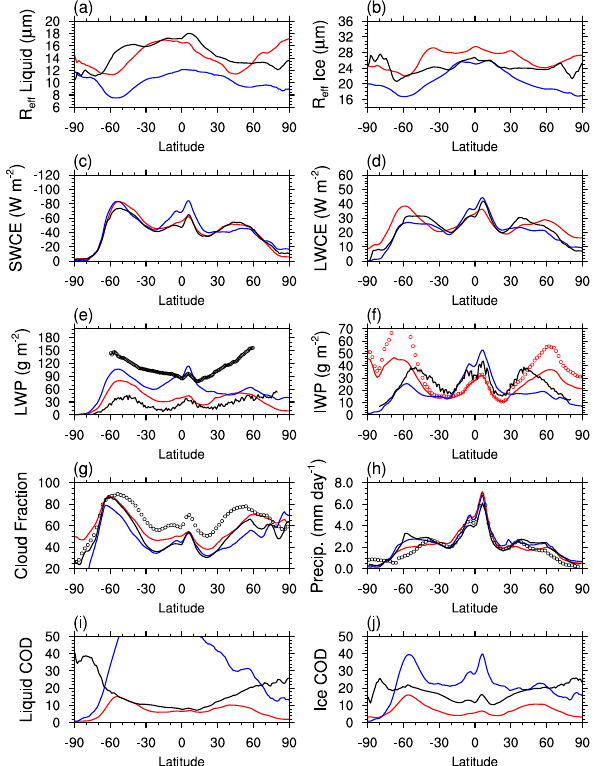
Figure 15. Annual zonal means from the GEOS-5 model for the CTL (blue lines) and NEW (red lines) runs compared against dif- ferent observations (black lines). (a, b) Liquid ( R eff , liq ) and ice ( R eff , ice ) effective radius from COSP output against MODIS. (c, d) Shortwave (SWCF) and longwave (LWCF) cloud forcing against CERES-EBAF retrievals (Loeb et al., 2009). (e) Liquid water path against CloudSat (black lines) and MODIS (black circles) retrievals. (f) Non-convective, non-precipitable ice water path against Cloud- Sat retrievals (Li et al., 2012, 2014). Also shown is the total (ice and snow) non-convective ice water path (red circles) from GEOS-5 us- ing the new microphysics. (g) Total cloud fraction from COSP out- put against MODIS (black lines) and ISCCP (black circles). (h) To- tal precipitation against GPCP data (Huffman et al., 1997). Also shown are data from the CMAP data set (Xie and Arkin, 1997) (black circles). (i, j) Liquid and ice optical depth (COD) from COSP output against MODIS retrievals.